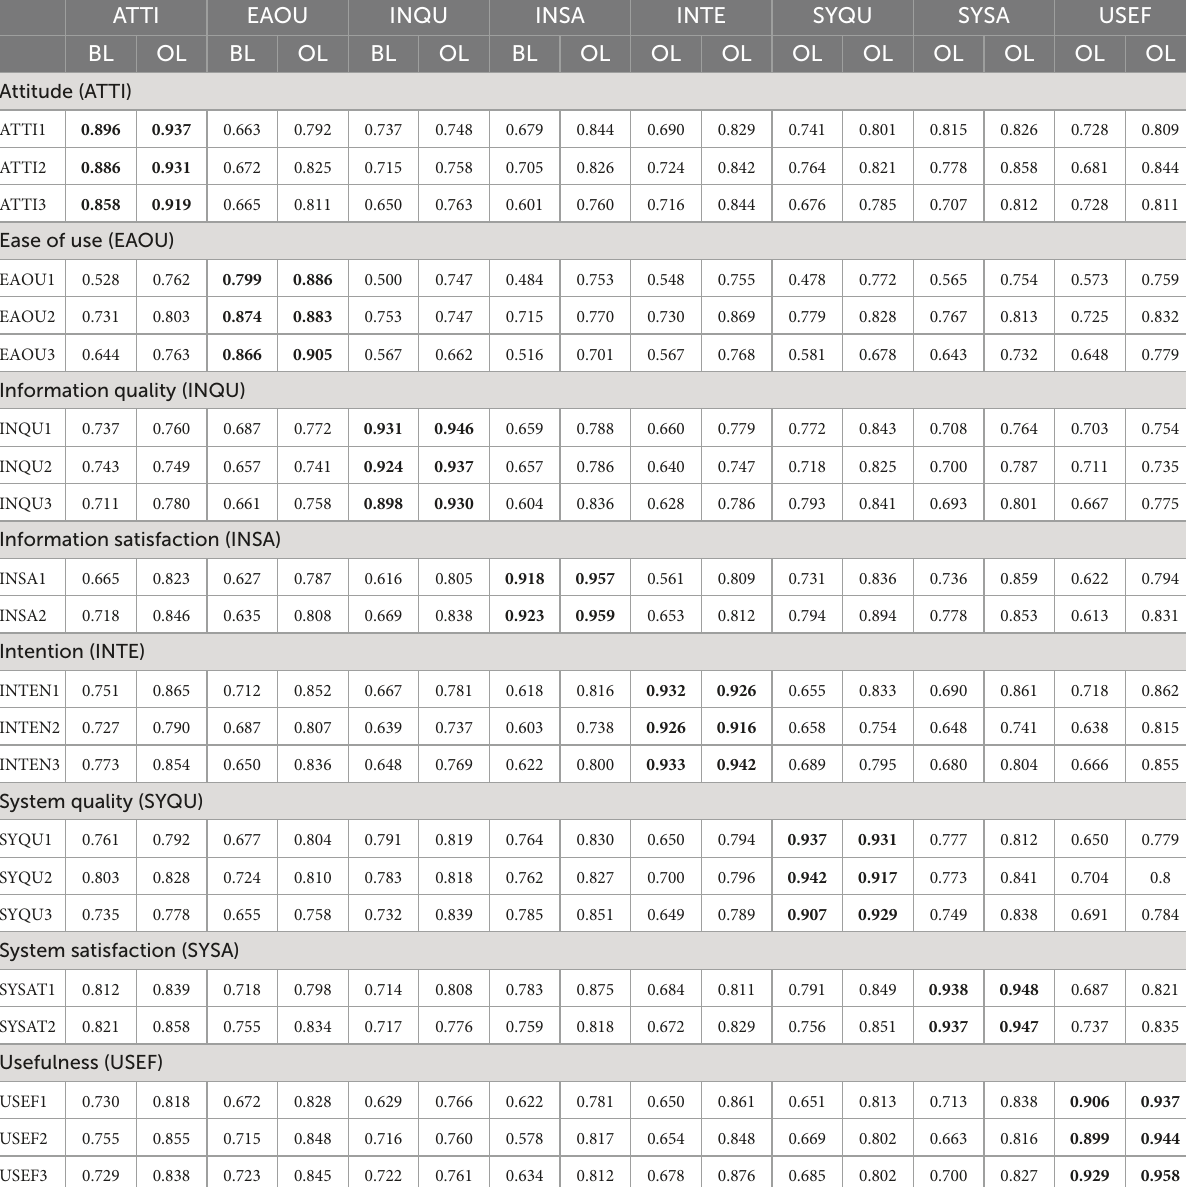
TABLE 3 Cross-loadings of the variables in the measurement models of BL and